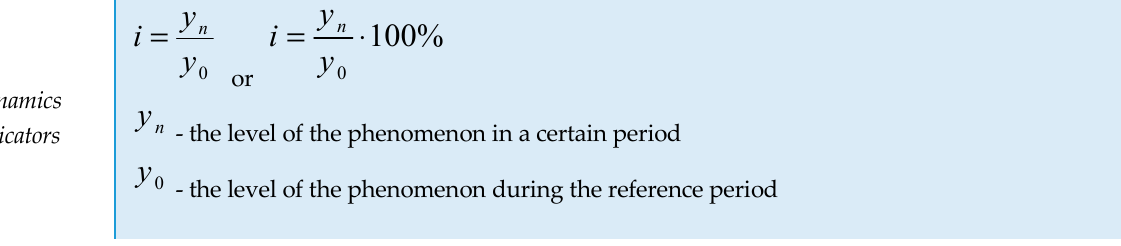
Figure 3. Dynamics indicators Figure 3 . Dynamics indicators formula .